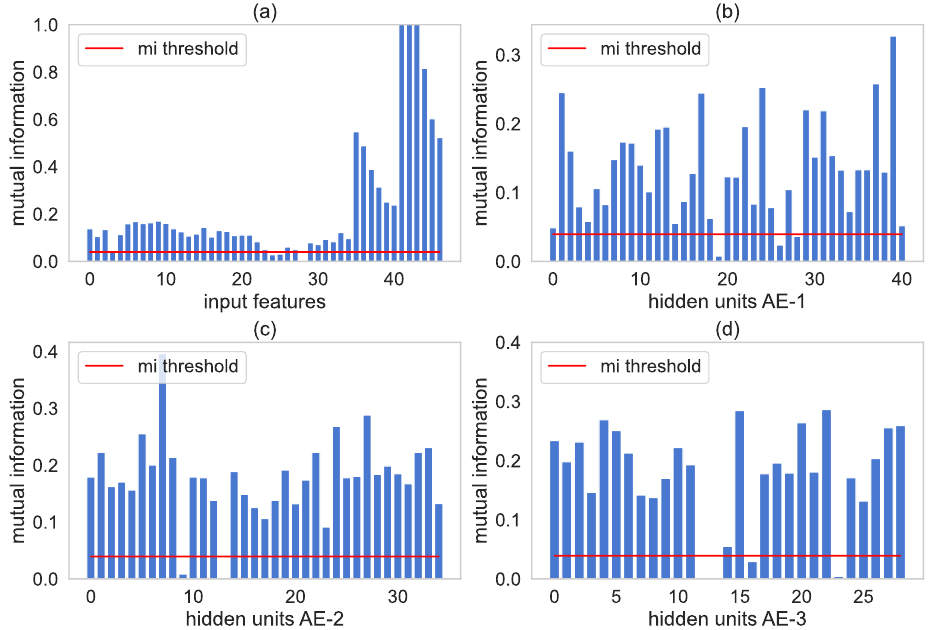
Figure 11. MI between input representations and the output variables for the SRU process. Subfigure ( a ) illustrates MI values of the input features. In addition, subfigures ( b – d ) indicate MI values hidden units present in AE-1, AE-2, AE-3,